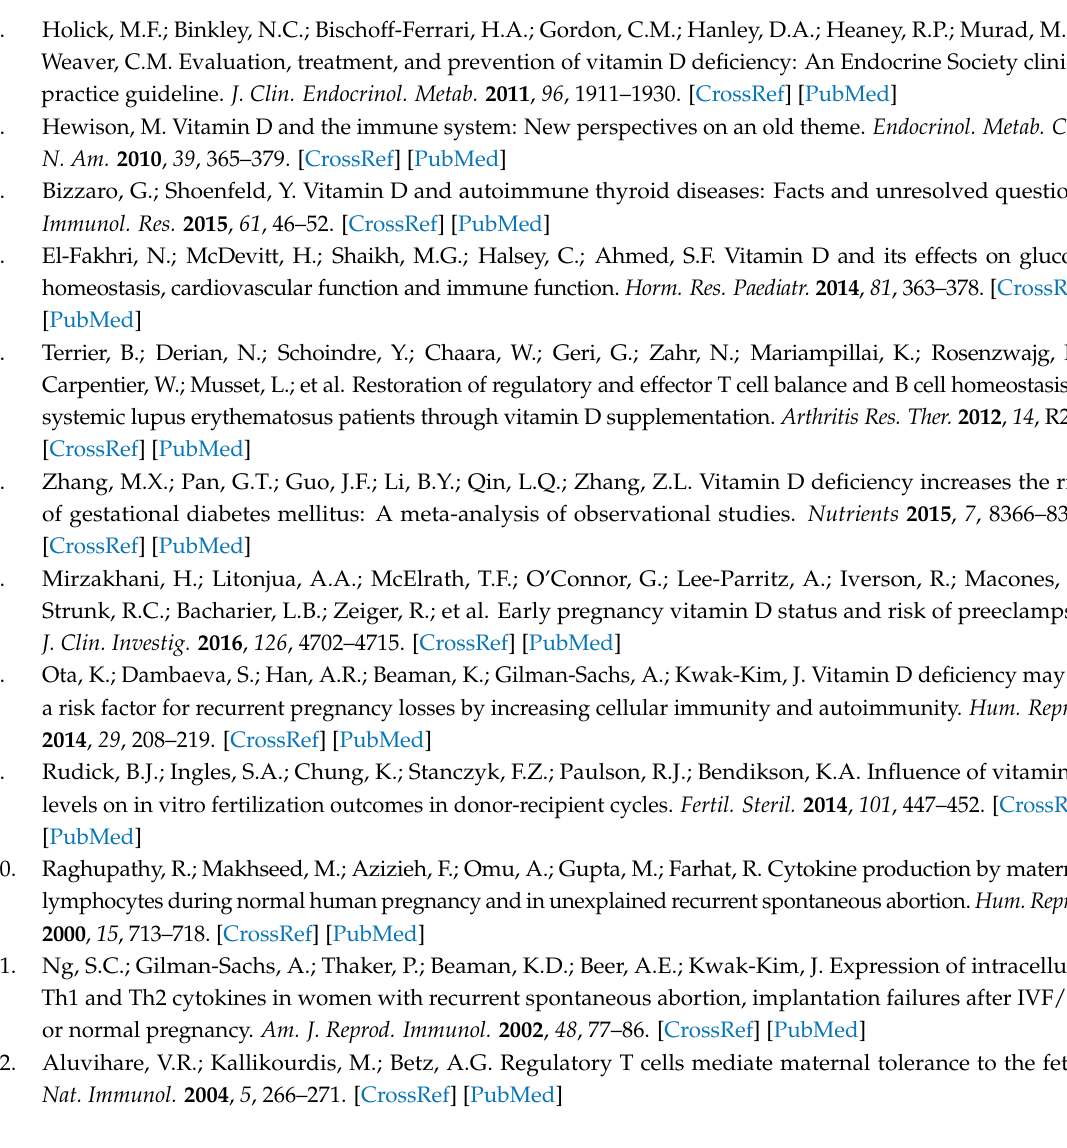
Figure S1: RTQ-PCR analysis of IGFBP1 and PRL transcript levels in HESCs treated with 8-bromo-cAMP and P4 combined with or without 1,25(OH) 2 VD for 4 days, Table S1: Patient characteristics, Table S2: Relationship of 25(OH)VD and